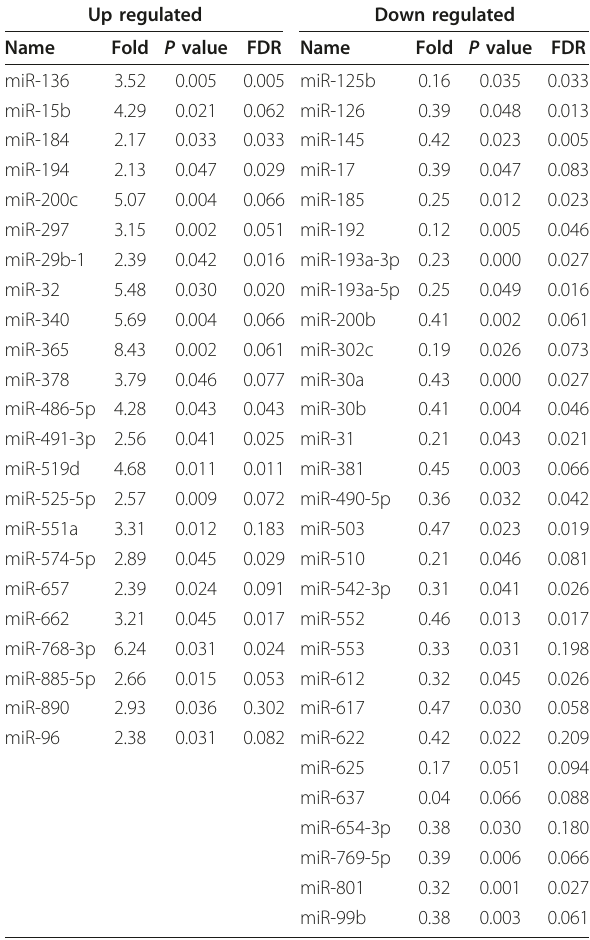
Table 1 miRNAs differentially expressed in GH-secreting pituitary adenomas vs. normal pituitaries